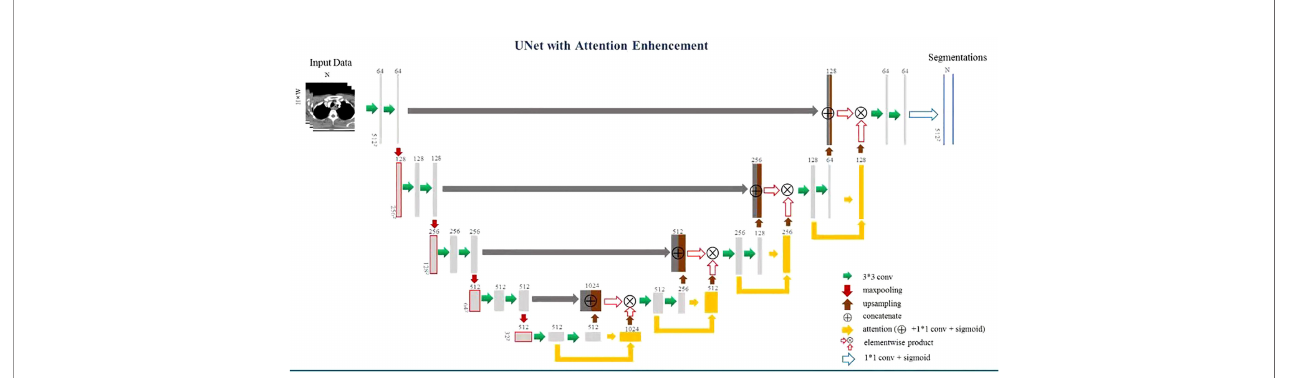
FIGURE 2 | Architecture of the 2D U-Net-based